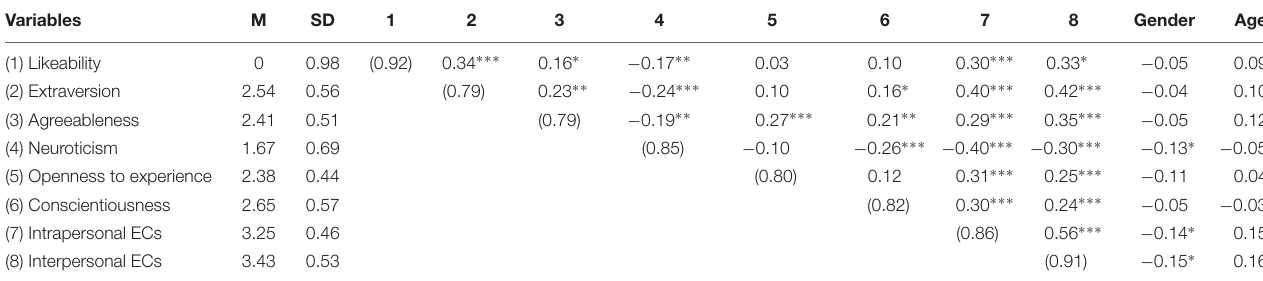
TABLE 1 | Internal consistency reliability (Cronbach’s α ), means, standard deviations and intercorrelations among all study variables. Variables M